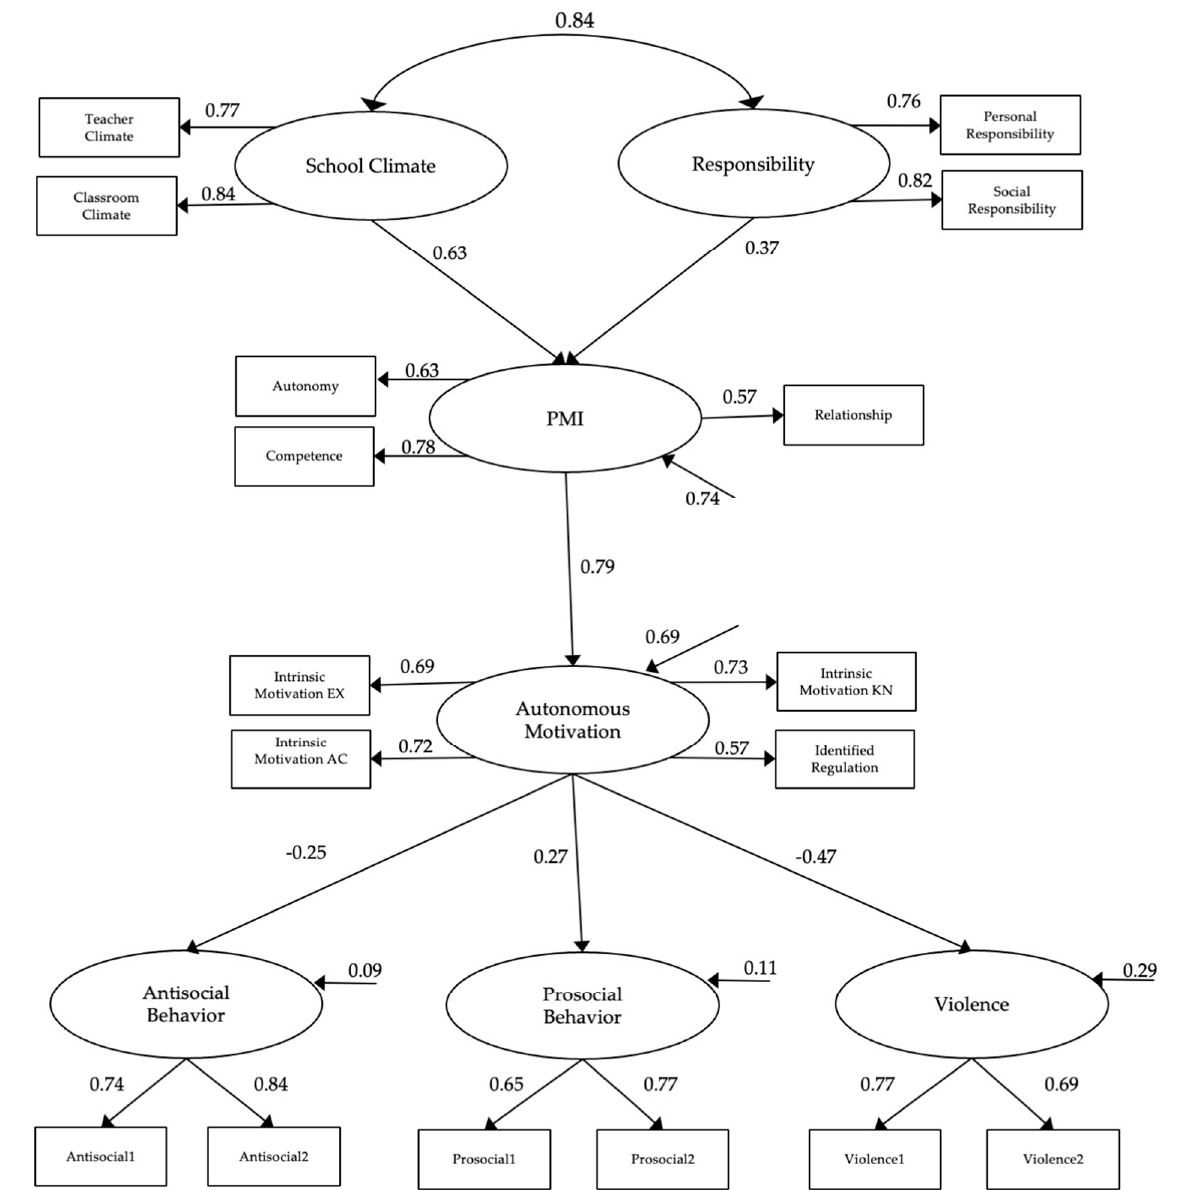
Figure 1. Model with relationships between school climate, responsibility, psychological mediator index (PMI), autonomous motivation, prosocial and antisocial behavior, and violence.